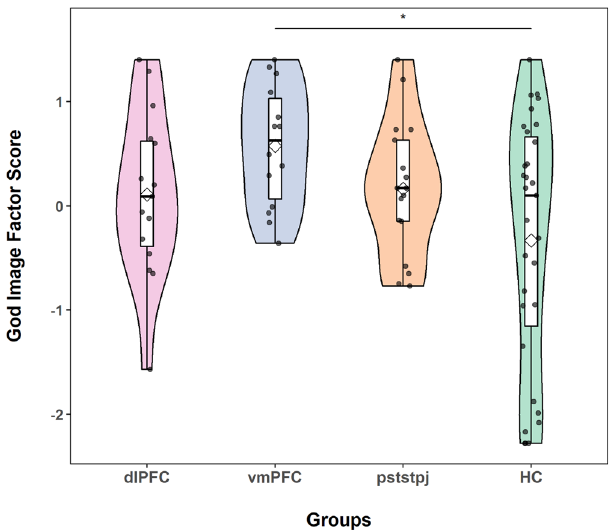
Figure 1. God Image Factor Score violin/boxplots for the different groups. Participants with vmPFC damage demonstrated higher scores on the God Image scale than HCs (p < 0.05). The boxes indicate the 75th percentile (upper horizontal line), the mean of each group (diamond), the median for each group (line), and the 25th percentile (lower horizontal line) of the distribution. Each dot indicates a participant. The upper whiskers indicate the maximum value of the variable located within a distance of 1.5 times the interquartile range above the 75th percentile. The lower whiskers indicate the corresponding distance to the 25th percentile value. Surrounding the boxes (shaded area) on each side is a rotated kernel density plot, which is comparable to a histogram with infinitely small bin sizes. The figure was generated using the package ggplot2 41 in R 42 .